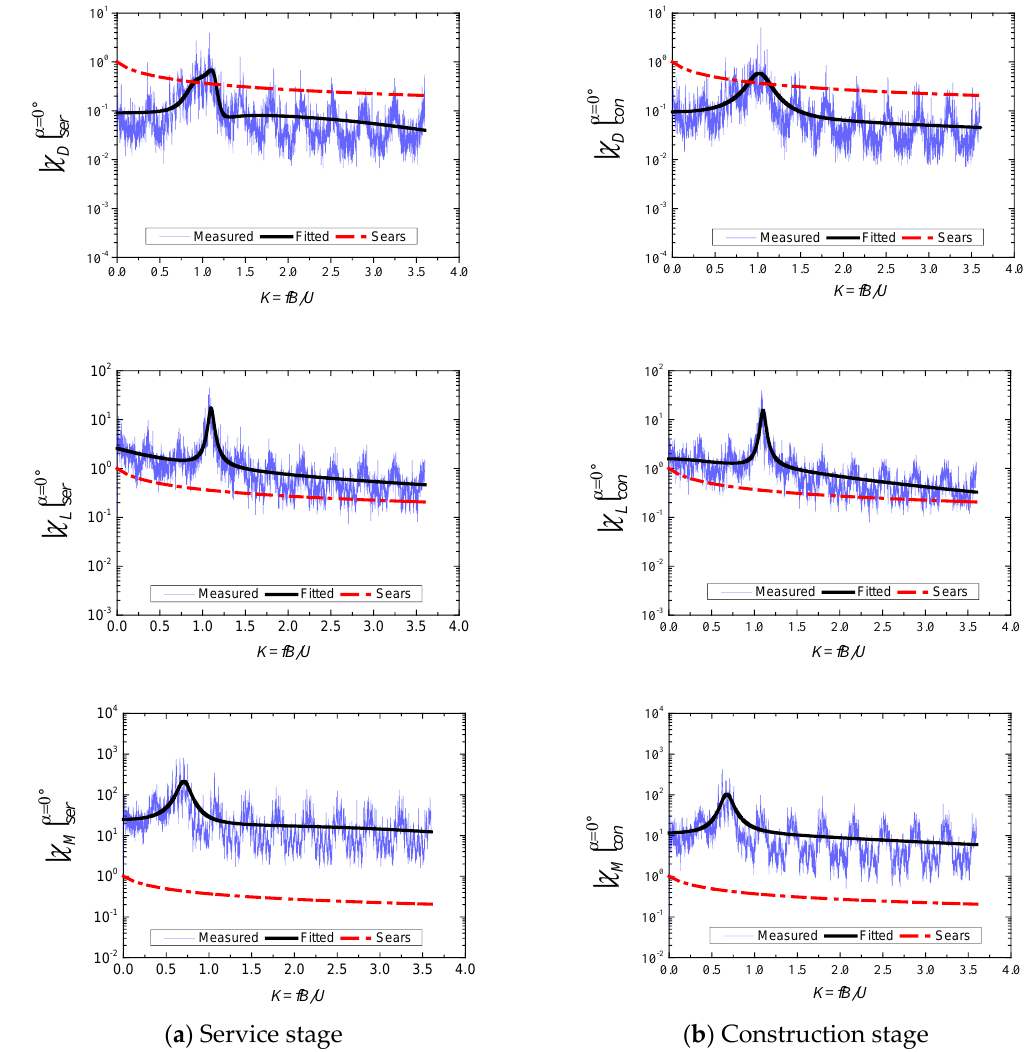
Figure 8. AAFs (aerodynamic admittance functions) identified for the DDTG under the service and construction stages at α = 0 ◦ .